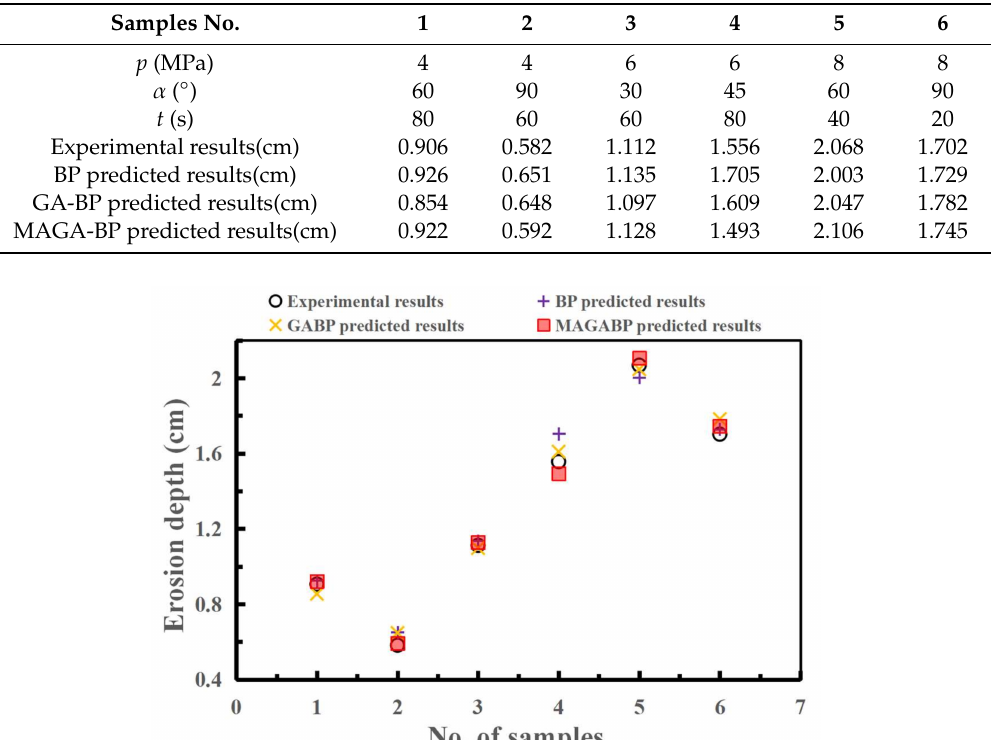
Table 10. Results of di ff erent prediction models.